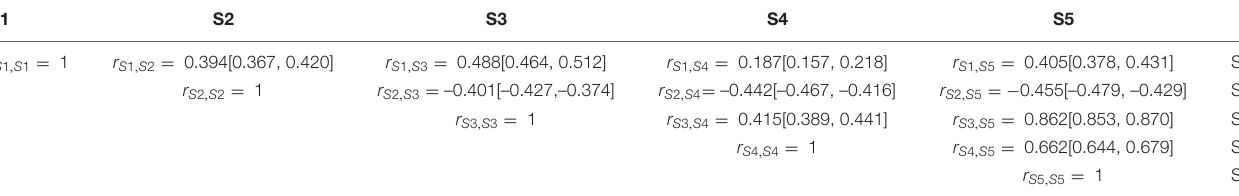
TABLE 1 | Correlation coefficient r between daily saltwater transports T sal through cross-sections S1–S5 calculated from the 10-year time series. S1 S2 S3 S4 S5 r S 1 , S 1 = 1 r S 1 , S 2 = 0.394[0.367, 0.420]